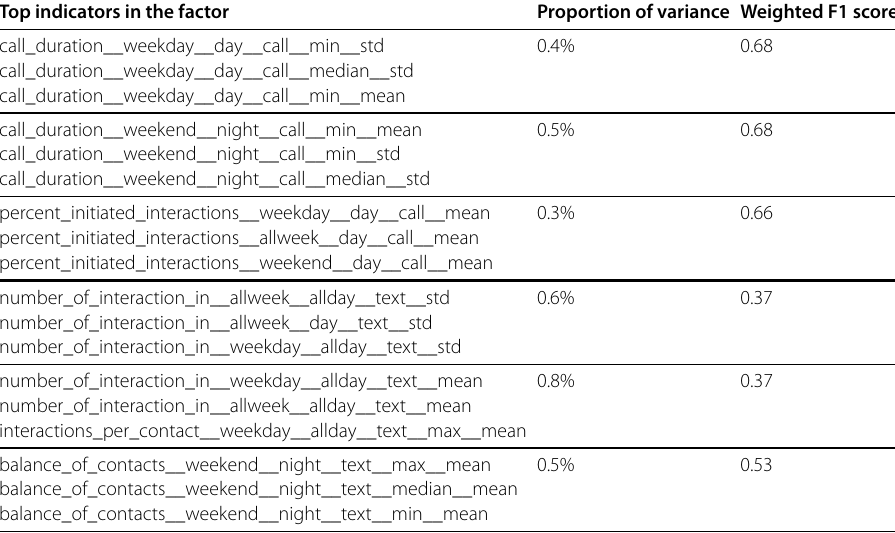
Table 5 The most (top 3) and least (bottom 3) predictive factors of gender in the South Asian data Top indicators in the